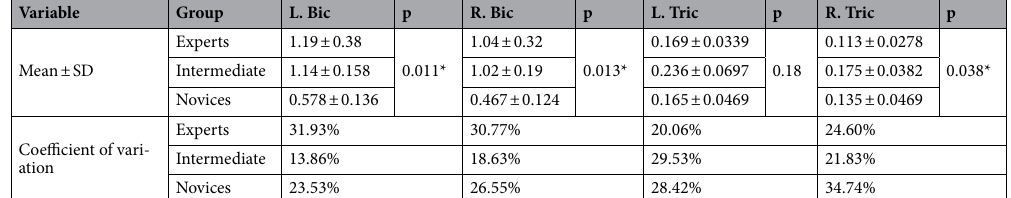
Table 3. Duration of muscle activation time during the free-throw missed [s] (mean ± standard deviations). * Statistical significance >0.05.